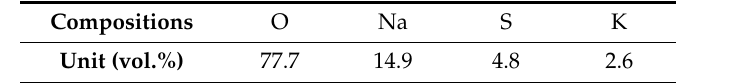
Table 3. Chemical composition of admixture.